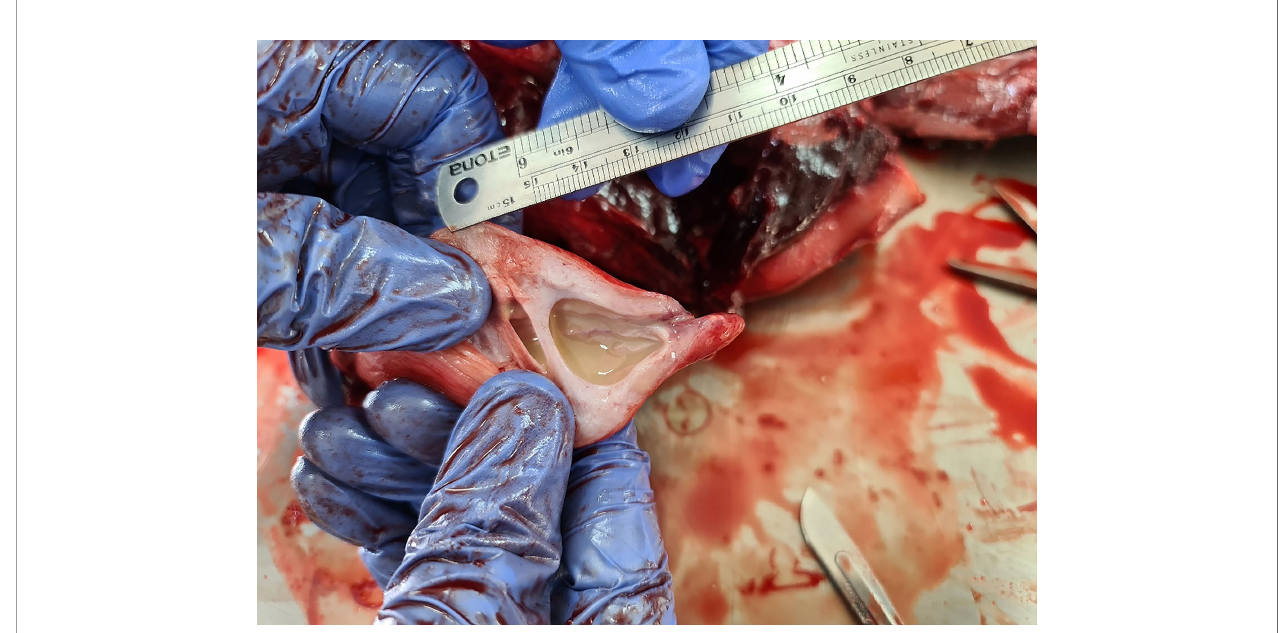
FIGURE 1 | Gross pathology of the urinary bladder of a common dolphin ( Delphinus delphis ). About fi ve ml of mucopurulent discharge was observed in the urinary